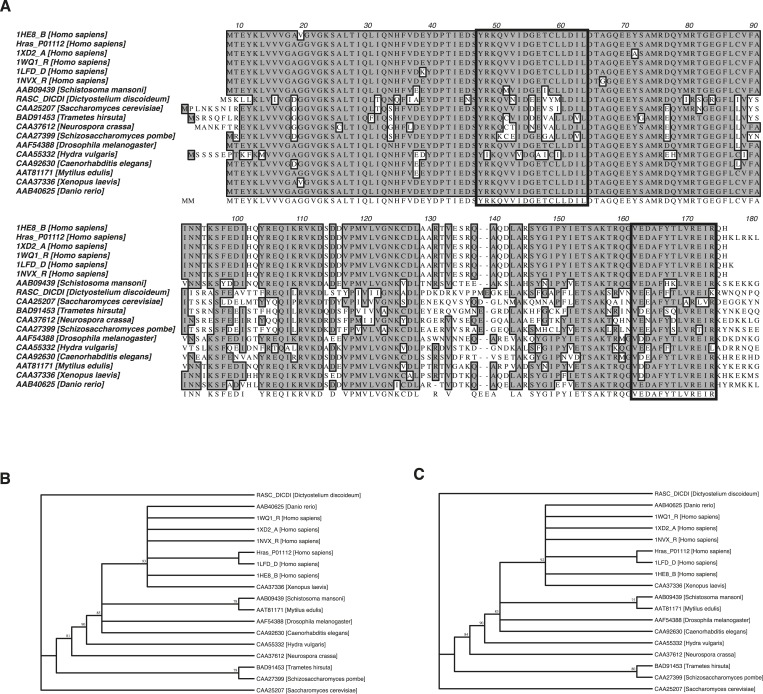
Phylogenetic analysis of the Ras switch III region.(A) ClustalW sequence alignment of 18 Ras proteins from different species as annotated on the left. Consensus sequence is shaded in dark and switch III region elements β2-β3-loop (residues 40–56) and helix α5 (residues 152–166) are highlighted with a black frame. (B) Unrooted phylogenetic trees were built from these proteins for the β2-β3-loop and (C) helix α5. (B, C) Numbers on internal branches indicate the percentage of 1000 bootstrap trials that support the branch (numbers <70% are omitted). Residues outside the region of interest were excluded using the position-masking tool for both phylogenetic analyses. The analysis revealed that switch III residues are highly conserved among all analyzed Ras proteins. The human Ras isoforms cluster together with other Ras proteins from the Bilateria species (D. rerio, X. laevis, S. mansoni, M. edulis, D. melanogaster, and C. elegans). Ras proteins from the Fungi kingdom (S. pombe and T. hirsuta) and Cnidaria phylum (H. vulgaris) species show a divergent pattern that corresponds to the speciation events that occurred in the course of evolution (∼1298 Ma for Bilateria—Cnidaria and ∼1513 Ma for Animalia—Fungi speciation event) (Hedges et al., 2004).